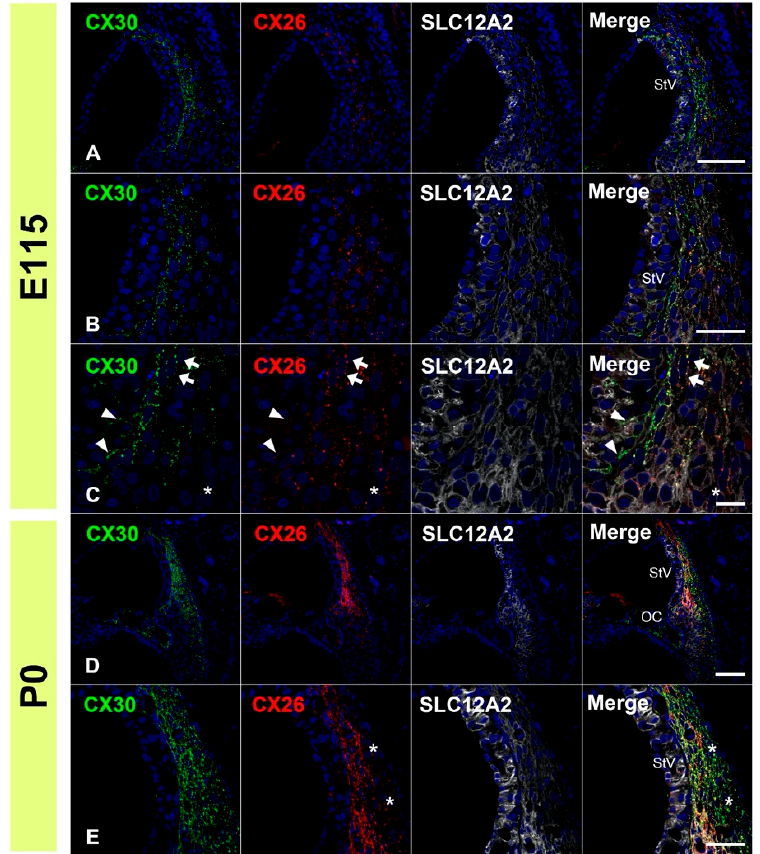
Figure 7. Comparison of the expression patterns of CX26 and CX30 at E115 and P0 in lateral wall fibrocytes. ( A – C ) At E115, both CX26 and CX30 expressions were detected in the upper half of the spiral ligament fibrocytes. At this stage, a relatively high expression of CX30 was observed. On the modiolus side (stria vascularis side), CX30 expression was predominantly observed, and, in several cells, only CX30 expression was detected (arrowhead in ( C )). CX26 expression was observed more laterally, and, on the lateral side of fibrocytes, only CX26 expression was detected (asterisk in ( C )). In the central region, overlapping expression of CX26 and CX30 was observed (arrow in ( C )). ( D – E ) At P0, both CX26 and CX30 were observed in the lateral wall fibrocytes and lateral side membrane of the basal cells of stria vascularis. In contrast to E115, the expression of CX30 was observed more broadly. On the lateral side of fibrocytes (type III fibrocytes), only CX30 expression was observed (asterisk in ( E )). SLC12A2 (NKCC1) was used to label stria vascularis and lateral wall fibrocytes. Nuclei were counterstained with Hoechst stain (blue). Scale bar: 100 µ m in ( A , D ), 50 µ m in ( B , E ), 20 µ m in ( C ). StV: stria vascularis, OC: organ of Corti. ( A – E ): basal